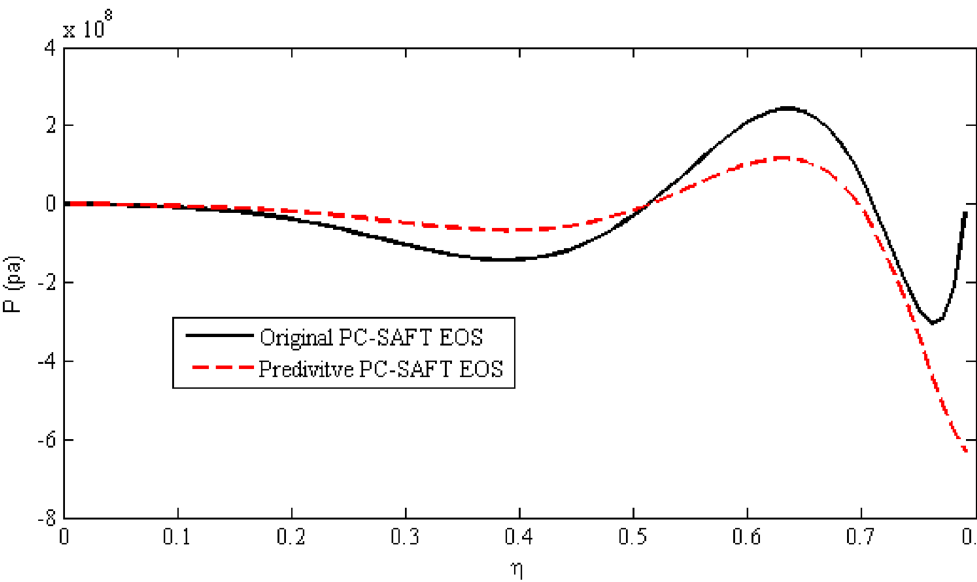
η plane of n-decane at T = 135 K from PC-SAFT EOS (solid line) and predictive PC-SAFT EOS Figure 4. P − (dashed